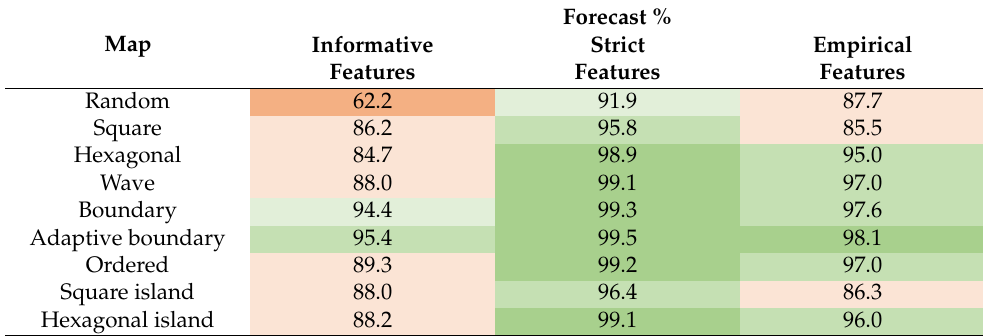
Square island Hexagonal